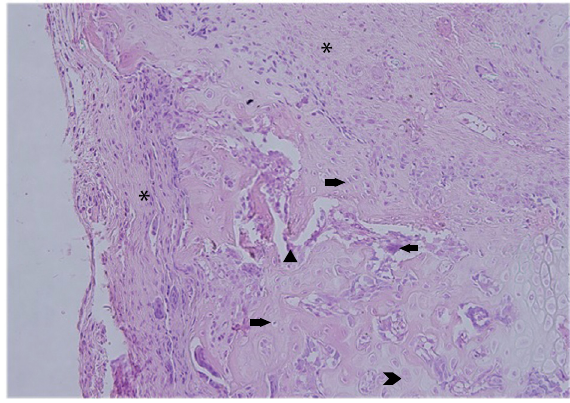
Figure 1. Fibrous tissue, osteocyte, osteoblast and calcified cartilage at 4th week evaluation.